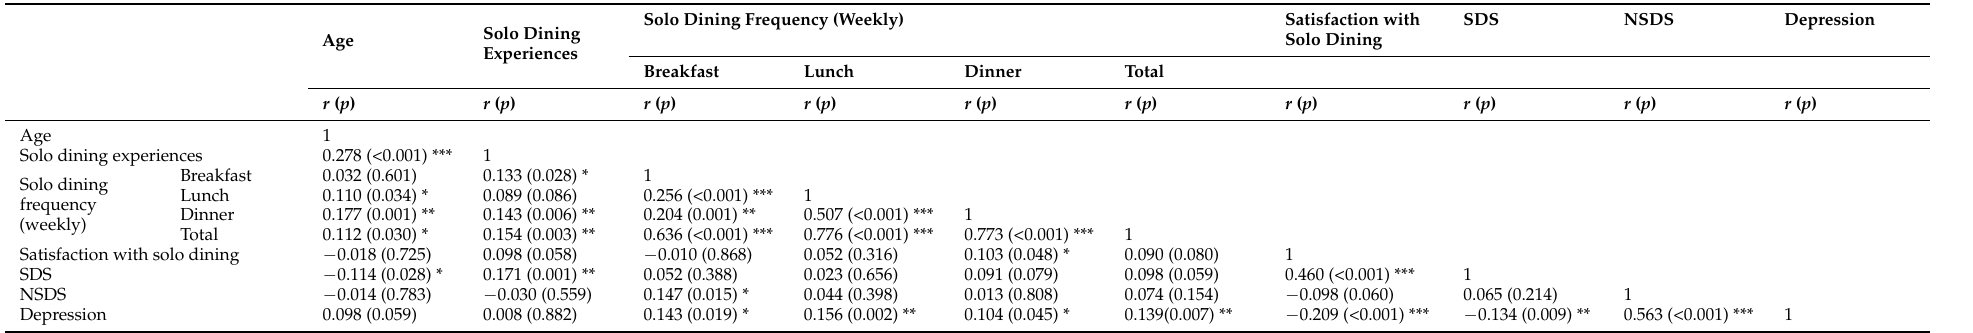
SDS NSDS Solo Dining